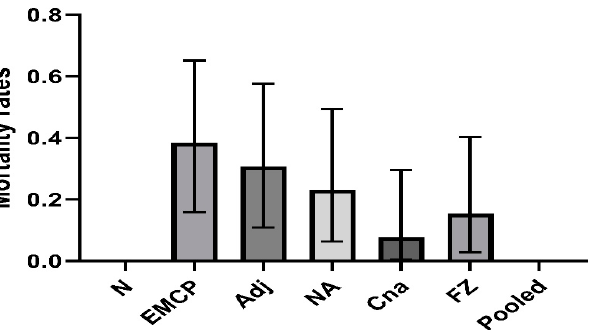
Figure 1. Mortality rates with 95% confidence intervals of vaccinated broiler chickens following necrotic enteritis challenges. Birds were immunized with recombinant proteins on Day 4 and Day 15: EMCP = positive challenge control; Adj = adjuvant + EMCP challenge; NA= chimeric NetB and Plc; FZ = chimeric FBA and Zm; Cna = collagen-binding protein; Pooled = pooled NA, FZ, and Cna an- tigens. The birds with 13 birds per group were then challenged with Eimeria maxima (EM, 5 × 10 3 oocysts/bird, oral gavage) on Day 22, followed by CP netB + tpel + LLY_Tpel 17 (1 × 10 9 cfu /bird, oral gavage) on Day 26. Mortalities were recorded after C. perfringens challenge.